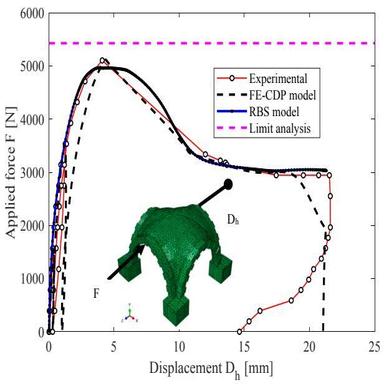
FRP-reinforced vault. Global force F-displacement Dh (DT4) curves obtained numerically and comparison with experimental data.